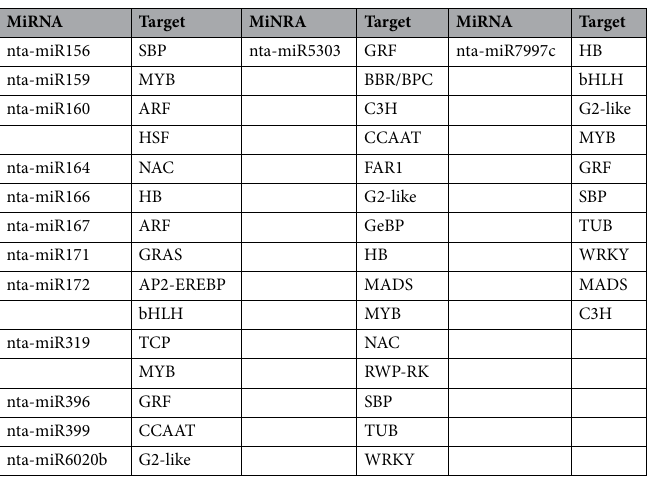
Table 3. Overview of transcription factor targets for known miRNA